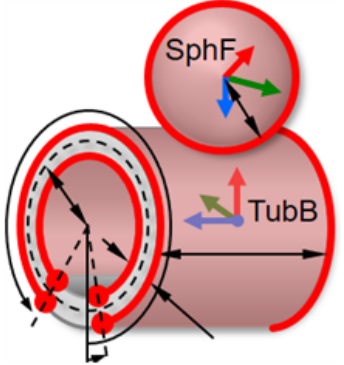
Figure 3. Sphere-to-Tube dimension.